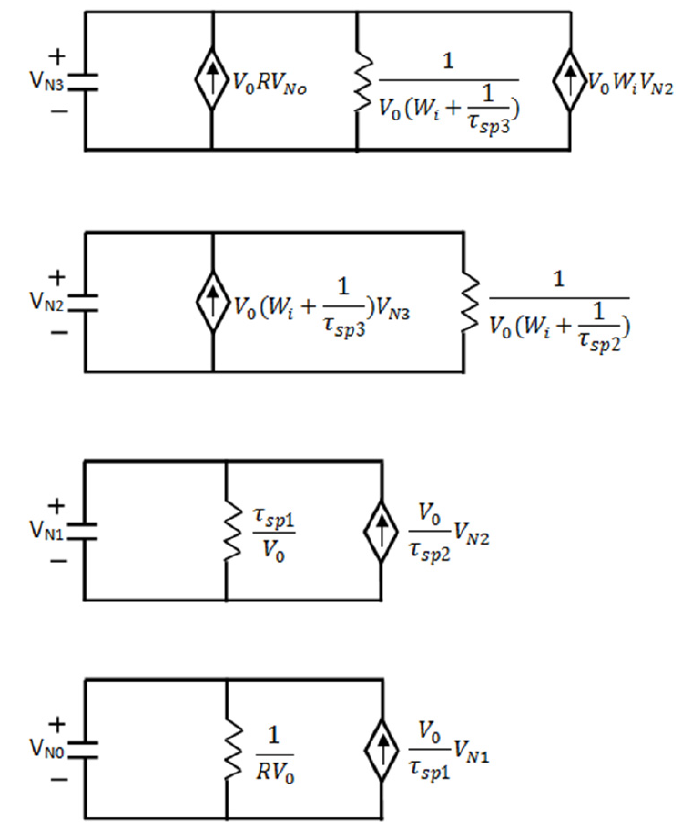
Figure 10. The analogous electrical model of atoms concentrations at each one of the four levels of the